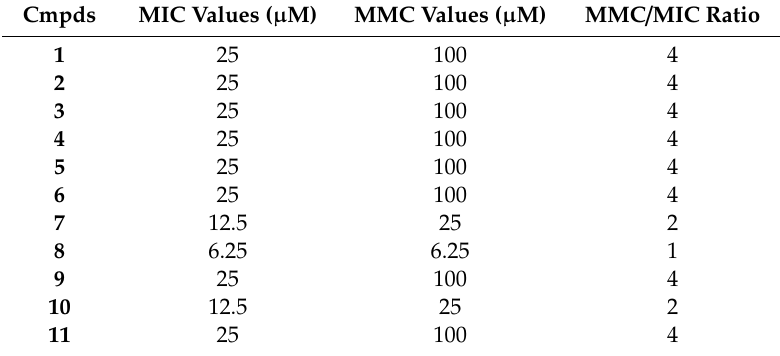
Table 1. In vitro antifungal activity. Minimum inhibitory concentration (MIC), minimum